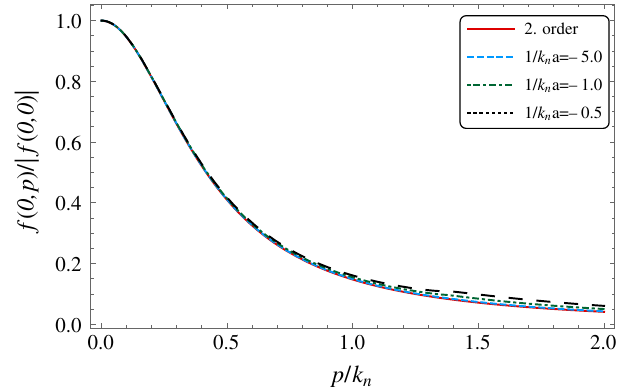
¼ B ¼ 0 . 2 , and a n B